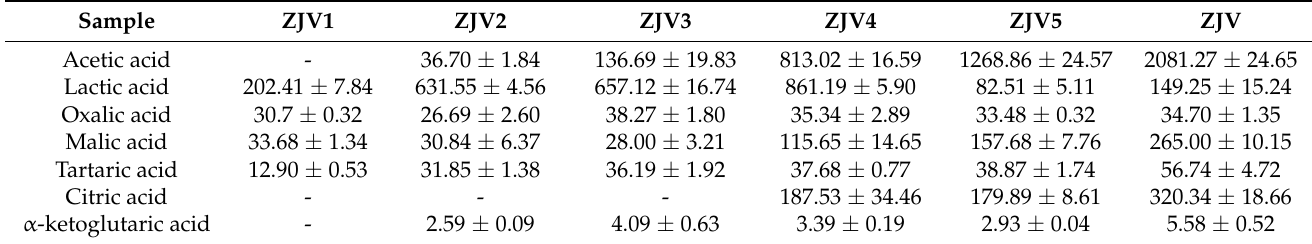
Table 1. Changes in the organic acid fractions of ZJV during